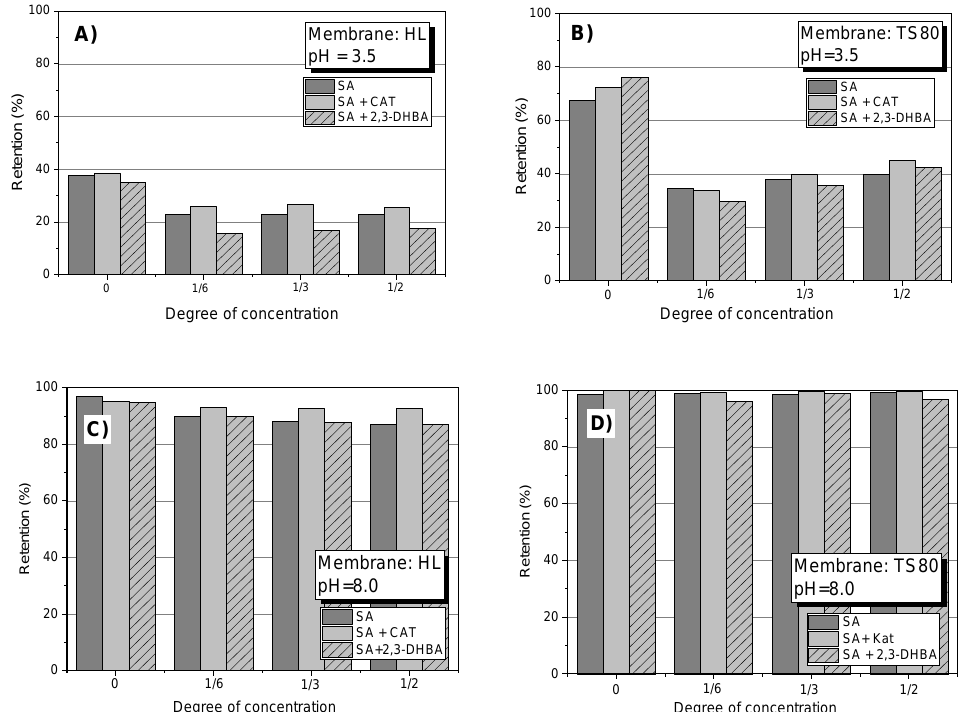
Figure 8. Retention coefficients of salicylic acid in the presence of 2,3-DHBA (2,3-dihydroxybenzoic acid) and catechol (CAT) at pH = 3.5 and pH = 8.0. SA- salicylic acid.